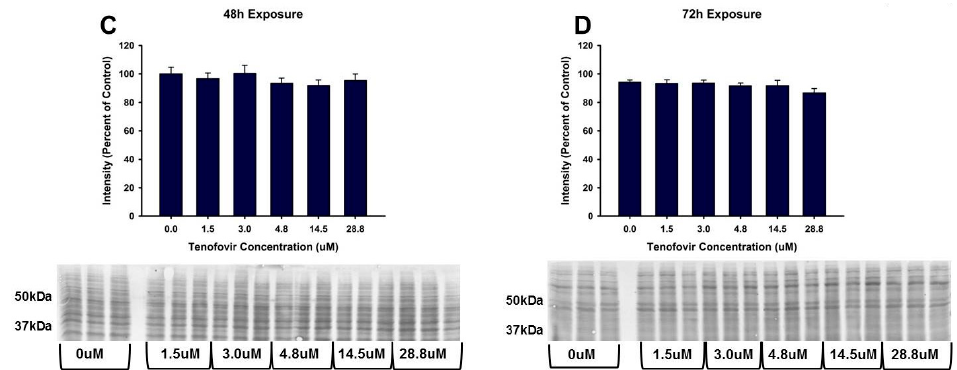
Figure 5. Tenofovir effects on 4-HNE adduct formation in HK-2 cells. 4-HNE adduct formation was measured in HK-2 cell lysate following 48 h ( A ) and 72 h ( B ) exposure to TFV. Representative blots and cumulative densitometry included in each panel. Representative blot with MemCode Reversible staining for equal 40 μ g protein loading and cumulative protein densitometry depicted for 48 h ( C ) and 72 h ( D ) exposure. Asterisks (* p < 0.05, *** p < 0.001) indicate statistical difference from the vehicle control group. Each bar represents Mean ± SEM for three independent experiments run with three biological replicates.